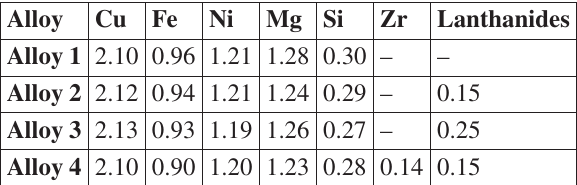
Table 1. Chemical composition of alloys (in mass